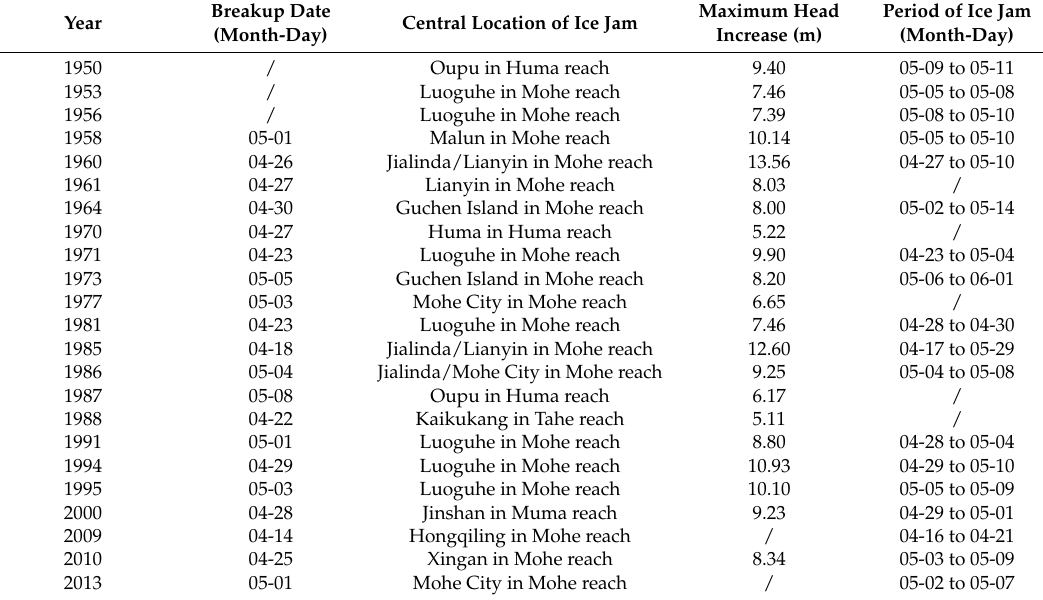
Table 1. Historical records of ice jam events on the Heilong River obtained from the Hydrological Bureau of Heilongjiang